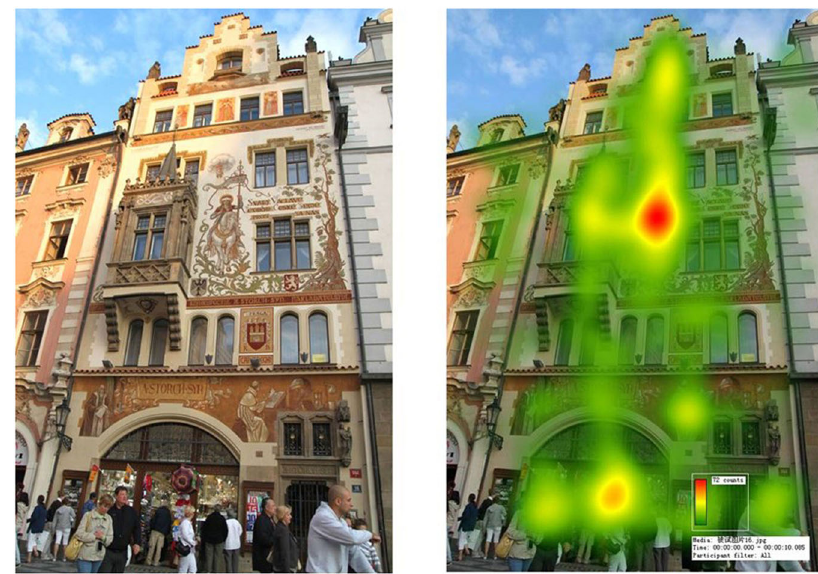
Fig. 17 The comparison of eye motion and heatmap for a typical building nearby Old Town Square.